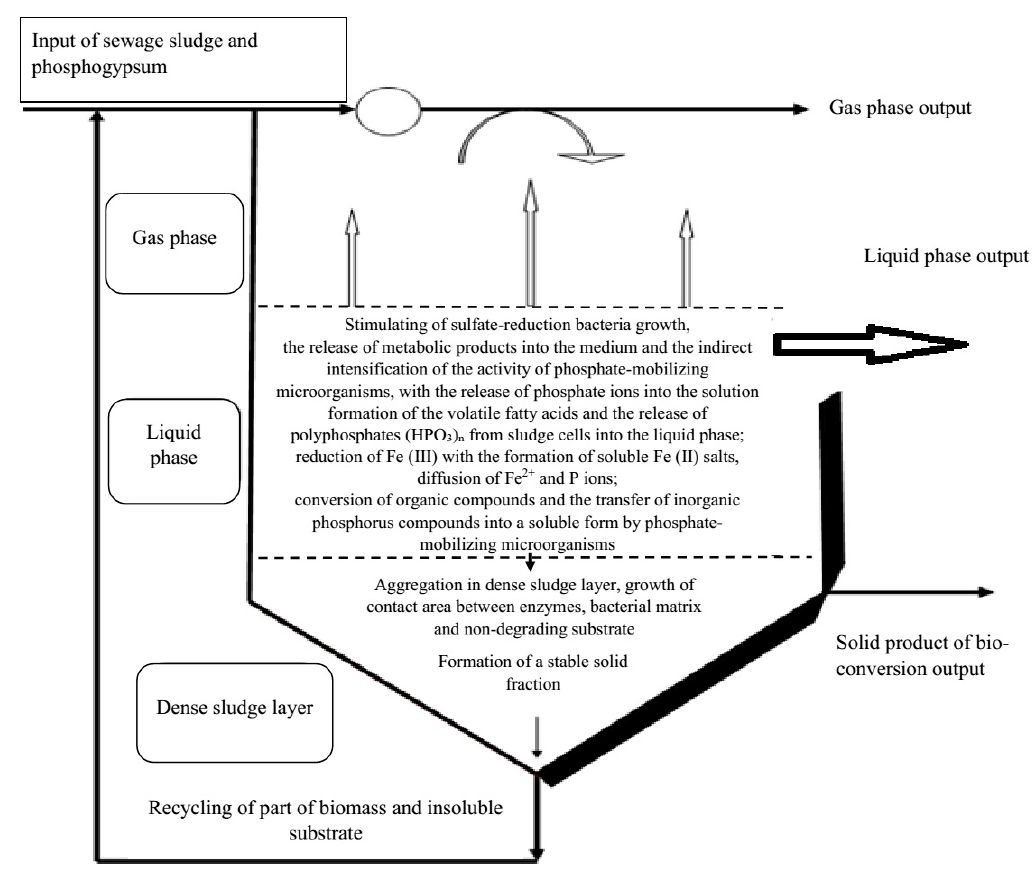
Figure 5. Formal model of the spatial distribution in the bioreactor in the phosphorus release process of sewage sludge and phosphogypsum under sulphate-reducing conditions.